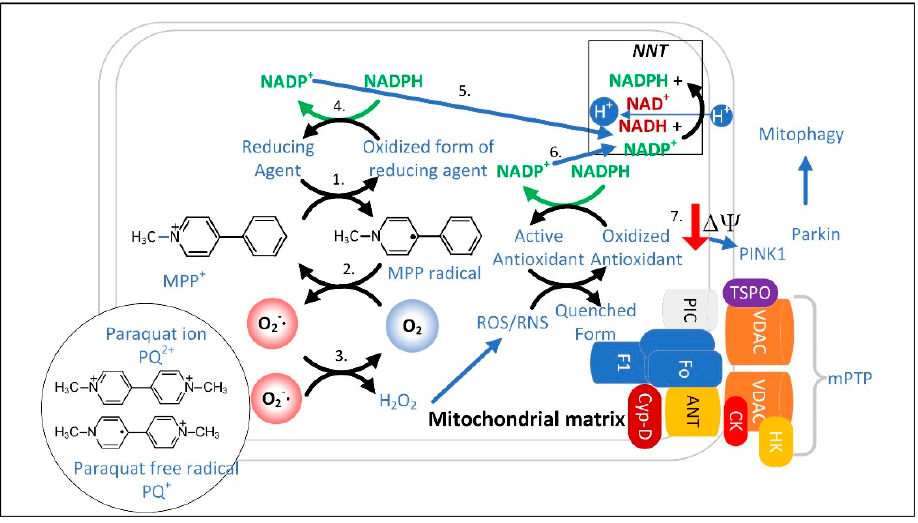
Figure 4. MPP + redox cycling occurs in mitochondria with a high membrane potential and leads